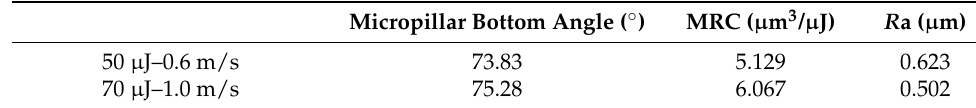
Table 3. Effect of different laser pulse energies and laser translation speeds on the micropillar bottom angle, MRC, and R a at the same micropillar height of 102 µ m.